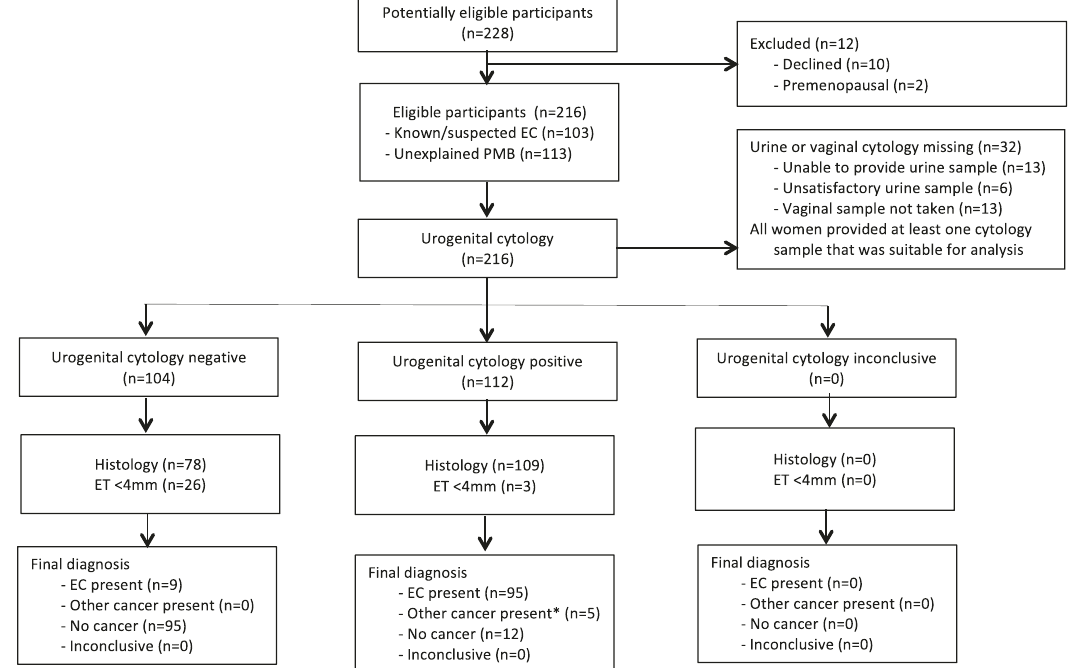
Fig. 1 STARD diagram showing fl ow of participants through the study. Key. ET, endometrial thickness; ET <4 mm, histology not indicated; EC, endometrial cancer; PMB, postmenopausal bleeding. *Other cancers: ovarian ( n = 1), fallopian tube ( n = 2), cervical ( n = 2). Cytology scoring: positive (vaginal and/or urine cytology positive); negative (both vaginal and urine cytology negative); inconclusive (both vaginal and urine cytology inadequate for